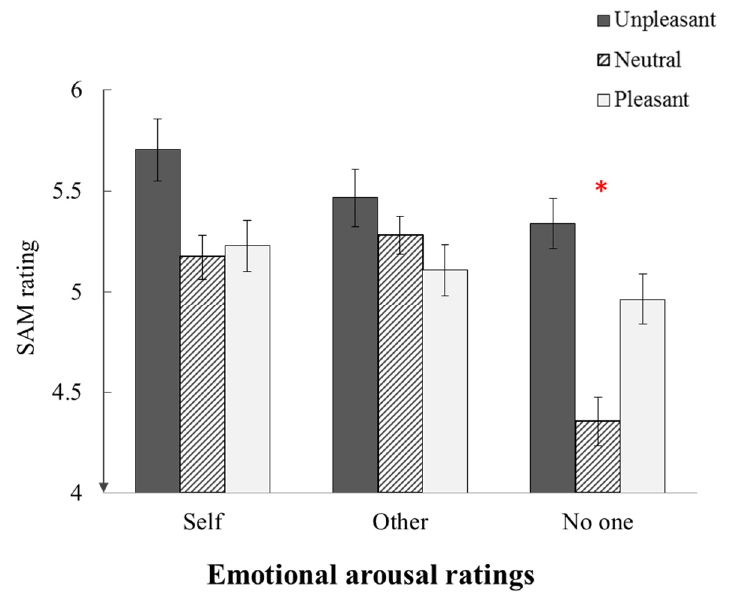
Figure 5. Mean arousal ratings for the final collection of stimuli. Arousal was rated on a scale of 1 (very calm) to 9 (very arousing). Error bars represent one standard error of the mean.* = the differences are significant at 0.05 alpha level.